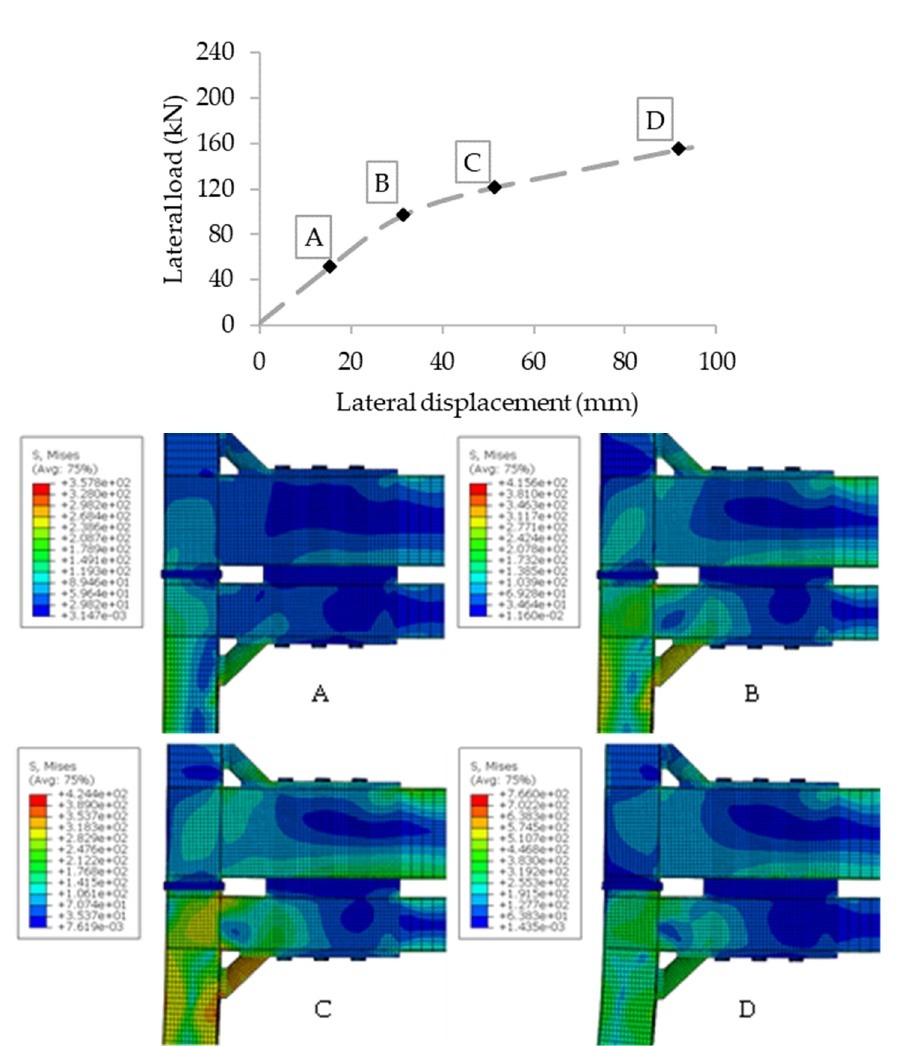
Figure 9. Response of the partially WAAM 3DMBC to the lateral loading.